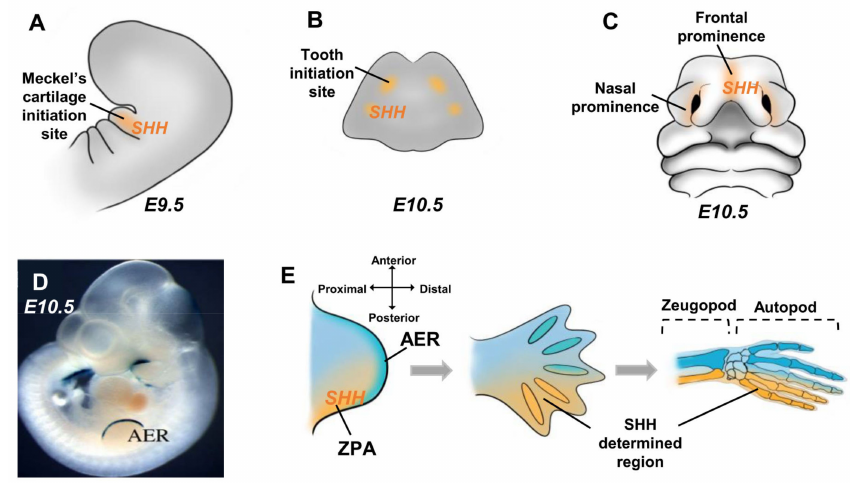
Figure 3. Sonic Hedgehog (SHH) implications in the craniofacial and limb morphogenesis. ( A ) SHH expression pattern in the first branchial arch determines the Meckel cartilage initiation site on mouse embryonic day 9.5 (E9.5). ( B ) SHH expression on mouse embryonic day 10.5 mandible determines the tooth initiation site. ( C ) SHH expression in the frontonasal prominences of the mouse embryonic day 10.5 governs the morphogenesis of the upper facial structures. ( D – E ) In the mouse limb bud at embryonic day 10.5, SHH expression in the zone of polarizing activity (ZPA) determines the posterior region of the limb bud, where distal growth is controlled by the apical ectodermal ridge (AER) visualized by Dlx2 / LacZ expression in ( D ) and the subjacent progression zone. The cells determined by the SHH signaling will give rise to the posterior bones of the autopod and zeugopod ( E